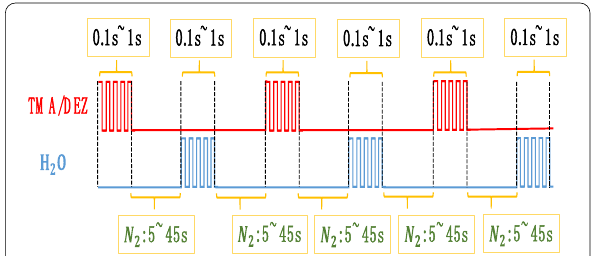
Fig. 3 Growing Al 2 O 3 and ZnO